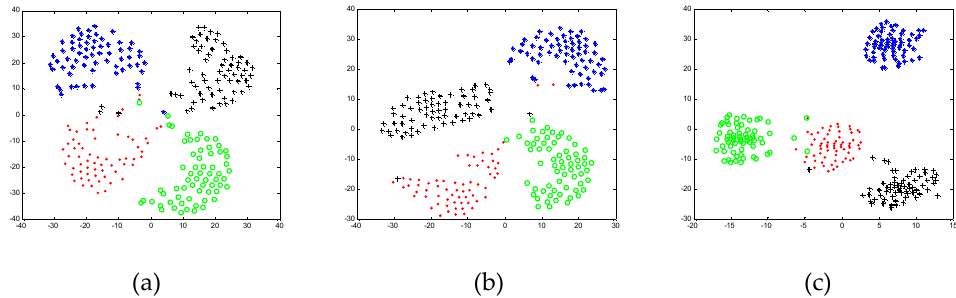
Figure 2. Results of two-dimensional projection on the Extended Yale B. ( a ) SPP; ( b ) DSNPE; ( c ) DSGE (the points of different colors represent the different subjects).